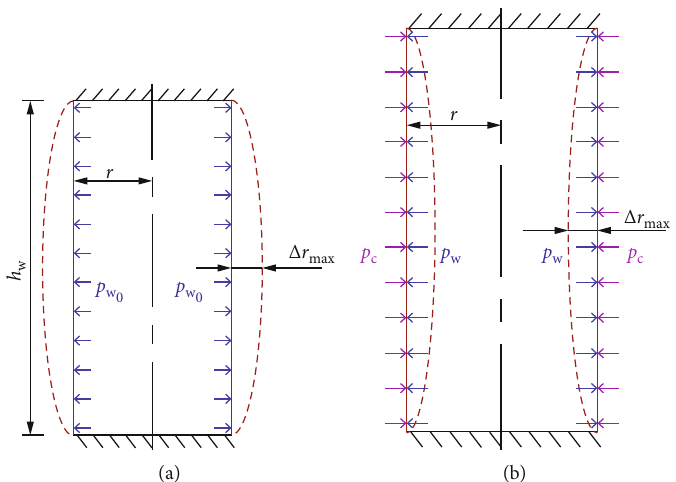
Figure 1: Mechanical models of the fl exible tubular membrane: (a) bulging due to the initial internal water pressure and (b) compressed by con fi ning